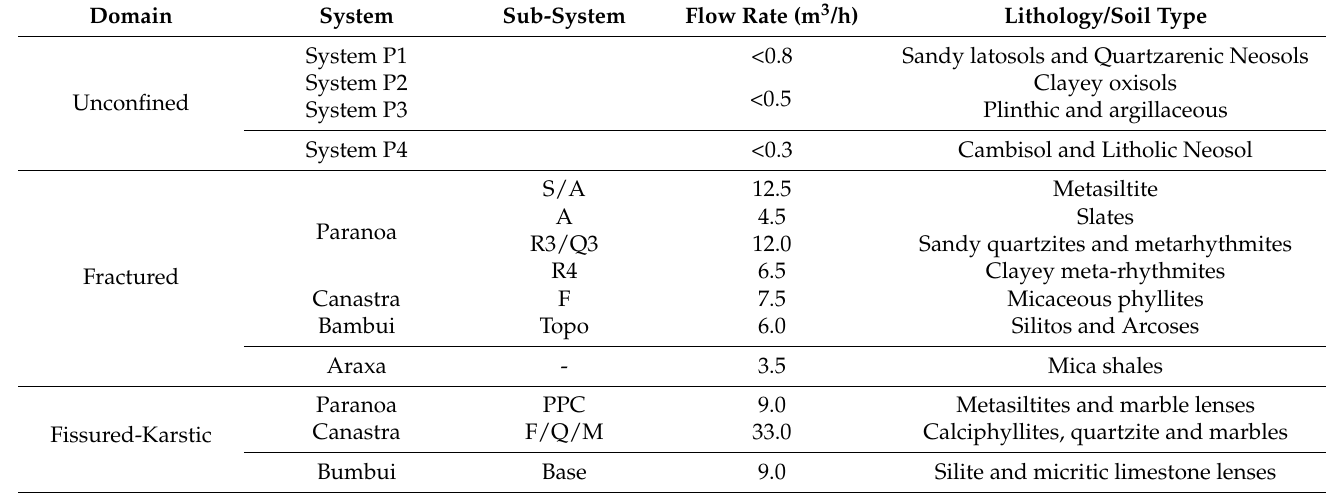
Figure 2. Geological units catalogued in Brasilia. Table 1. Classification of the Federal District aquifers based on flow rates, lithology, and soil type [18].